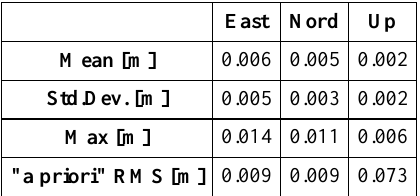
Table 1. Statistics of residuals on GCPs for RGB survey on bare soil.